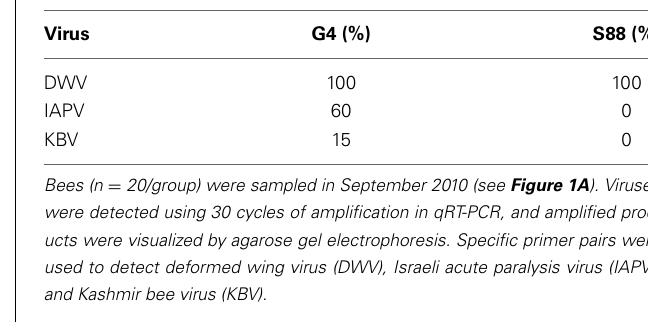
Table 5 | Percentage of resistant and susceptible adult bees with detectable